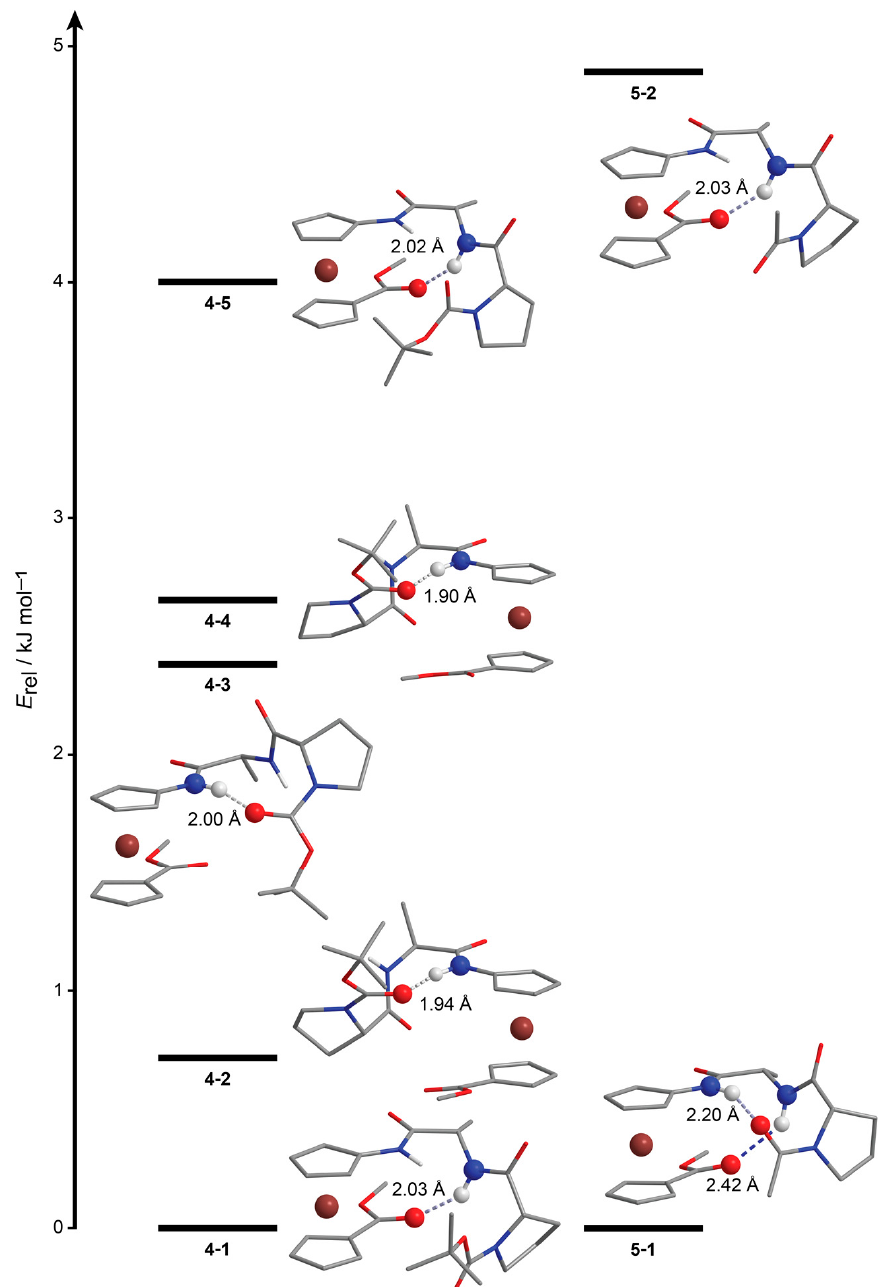
Figure 4. DFT optimized geometries of the most stable conformers of homochiral peptides 4 and 5 . Dashed lines represent hydrogen bonds confirmed by the QTAIM analysis. Nonpolar hydrogen atoms are omitted for clarity.